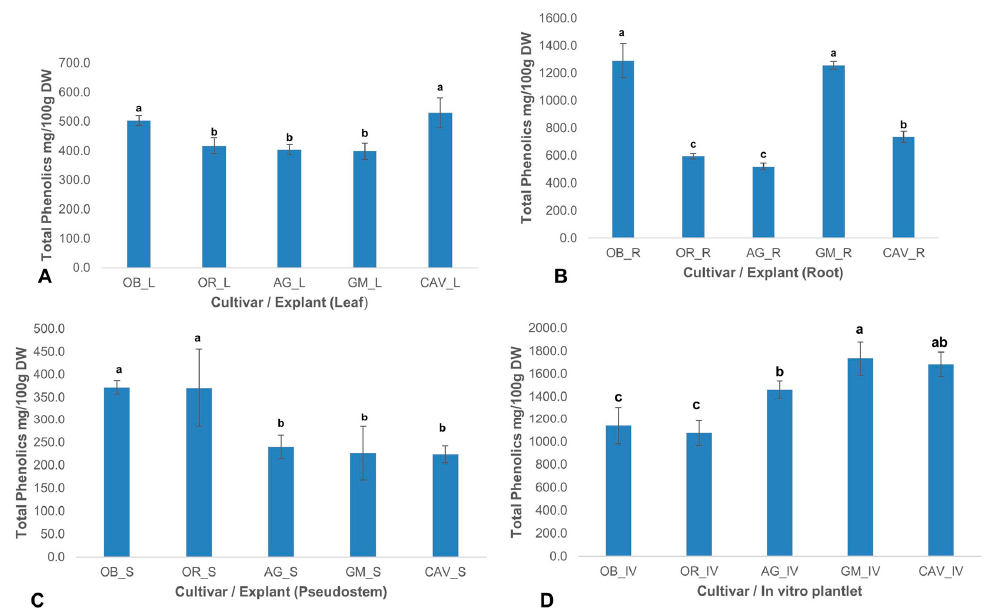
Figure 2. Total phenolics in various explants of field-grown plants and in vitro plantlets of different cultivars of banana and plantain. ( A ) Leaf (L) explant; ( B ) Root (R) explant; ( C ) Pseudostem (S) explant; ( D ) In vitro (IV) plantlet. Data are presented as means of triplicate samples ( n ≥ 3) and standard deviation. Means with different letters (a—c) are significantly different from each other at p ≤ 0.0001 (highly significant). OB—Obino l’Ewai; OR—Orishele; AG—Agbagba; GM—Gonja Manjaya; CAV—Cavendish Williams; DW—Dry weight of sample.